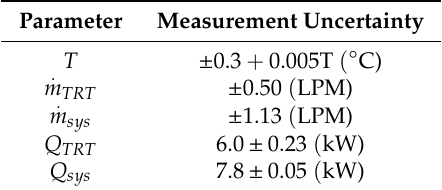
Figure 14. Average temperatures of the circulating fluid: ( a ) two years for the heating and cooling; ( b ) the representative three days for the heating period; ( c ) the representative three days for the cooling period. Table 3. Measurement uncertainty in the measured and the evaluated parameters.